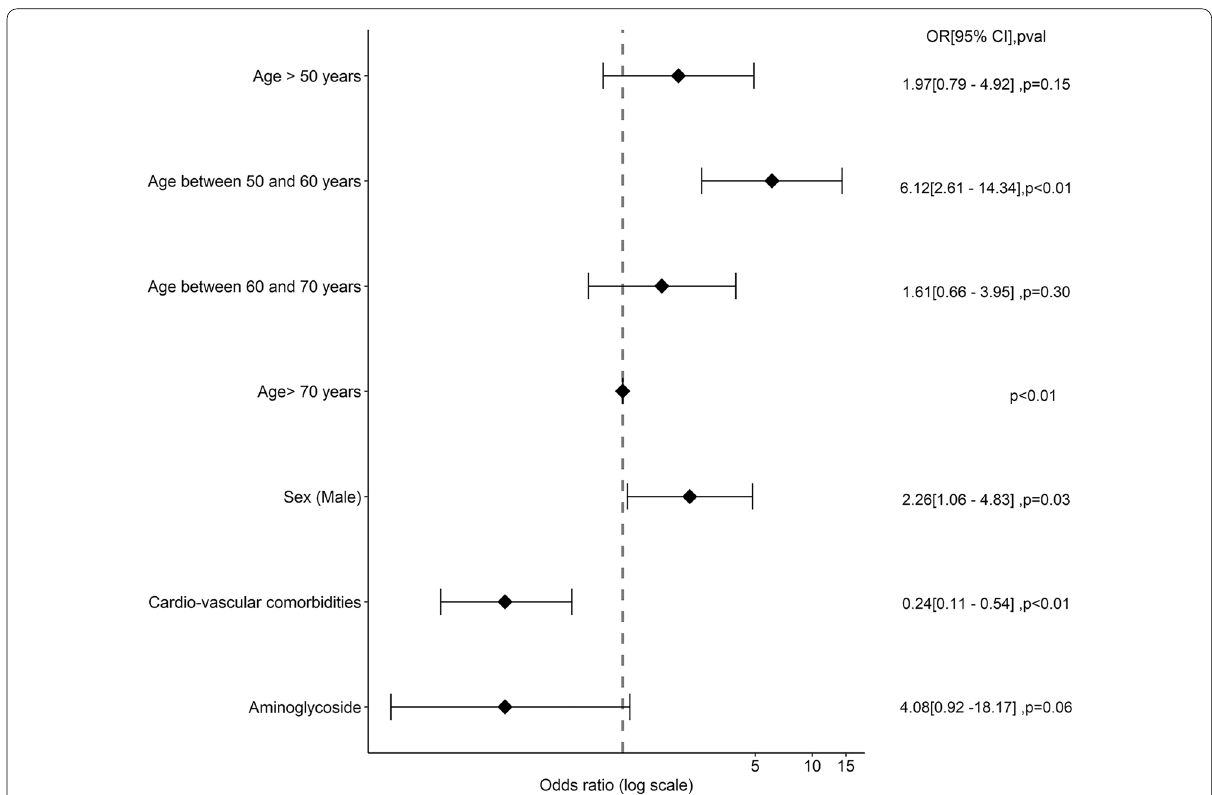
Fig. 2 Factors associated with ARC at admission. OR odds ratio, CI 95% confidence interval, HR hazard ratio. Factors tested in multivariate analysis for the of ARC at admission were age, sex (male), cardiovascular comorbidities, immunosuppression, diabetes, SARS‑COV2, catecholamines, invasive mechanical ventilation, proton‑pump inhibitors, enteral nutrition,